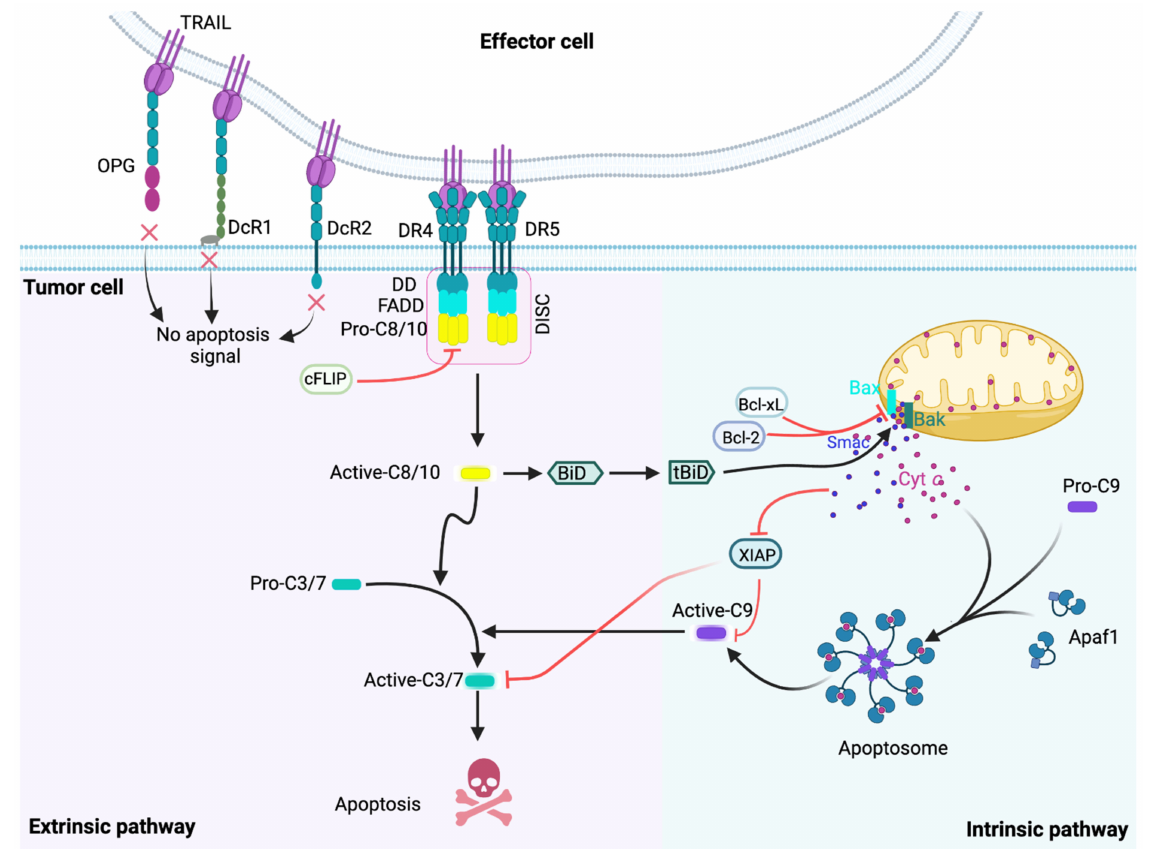
Figure 1. The TRAIL-induced cell death pathway and its regulation. Interaction of TRAIL with DR4 and DR5 leads to the recruitment of the adaptor protein, FADD, which then binds pro-caspase-8 and/or -10 leading to their activation. Activated caspase-8/-10 are released from the DISC into the cytoplasm, where they activate the downstream, effector caspases, which by cleaving vital proteins commit the cell to die. Caspase-8 can also cleave the BH3-only protein, Bid thus activating it. Truncated Bid (tBid) then binds and activates Bax and Bak, leading to mitochondrial membrane permeabilization and release of apoptotic factors such as Cyt c and Smac into the cytosol. Cyt c binds to APAF-1 thus initiating its oligomerization and recruitment of pro-caspase-9. The formed protein complex is called the apoptosome, serving as an activation platform for pro-caspase-9. Activated caspase-9 cleaves and activates the effector caspases, caspase-3/-6/-7, thus amplifying the DR- initiated apoptotic signal. Apoptosis signaling is kept under control at all stages of the process. First, decoy receptors (DcR1, DcR2) and osteoprotegerin (OPG) can sequester TRAIL thus preventing DR4/5 activation. cFLIP can interact and inhibit pro-caspase-8 in the DISC. At the mitochondrion, antiapoptotic Bcl-2 proteins, e.g., Bcl-2 itself and Bcl-x L inhibit Smac and Cyt c release. XIAP can inhibit caspase-3/-7/-9 activation; while Smac can block XIAP, thus allowing the apoptotic program to progress. TRAIL, tumor necrosis factor (TNF)-related apoptosis-inducing ligand; DR, death receptor; OPG, osteoprotegerin; DcR, decoy receptor; DD, death domain, FADD, Fas-associated death domain; Active/Pro-C, pro-caspase; DISC, death-inducing signaling complex; cFLIP, Cellular FLICE inhibitory protein; Cyt c , cytochrome c ; APAF-1, apoptotic protease-activating factor-1; Smac, XIAP,